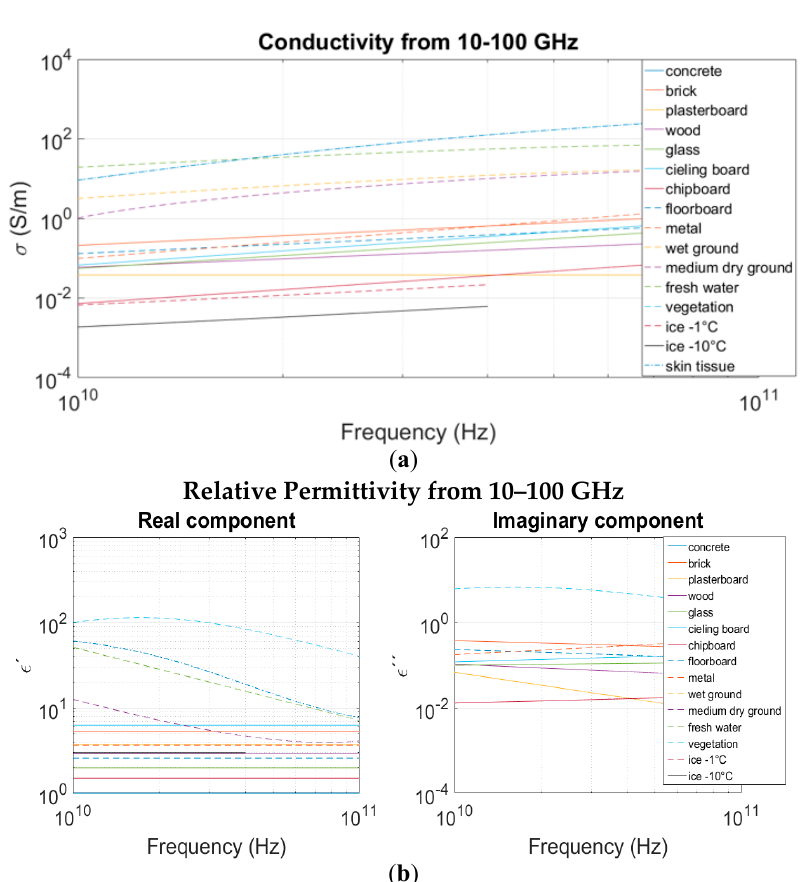
Figure 1. ( a ) Conductivity as a function of frequency for different materials, ( b ) Relative permittivity as a function of frequency for different materials.